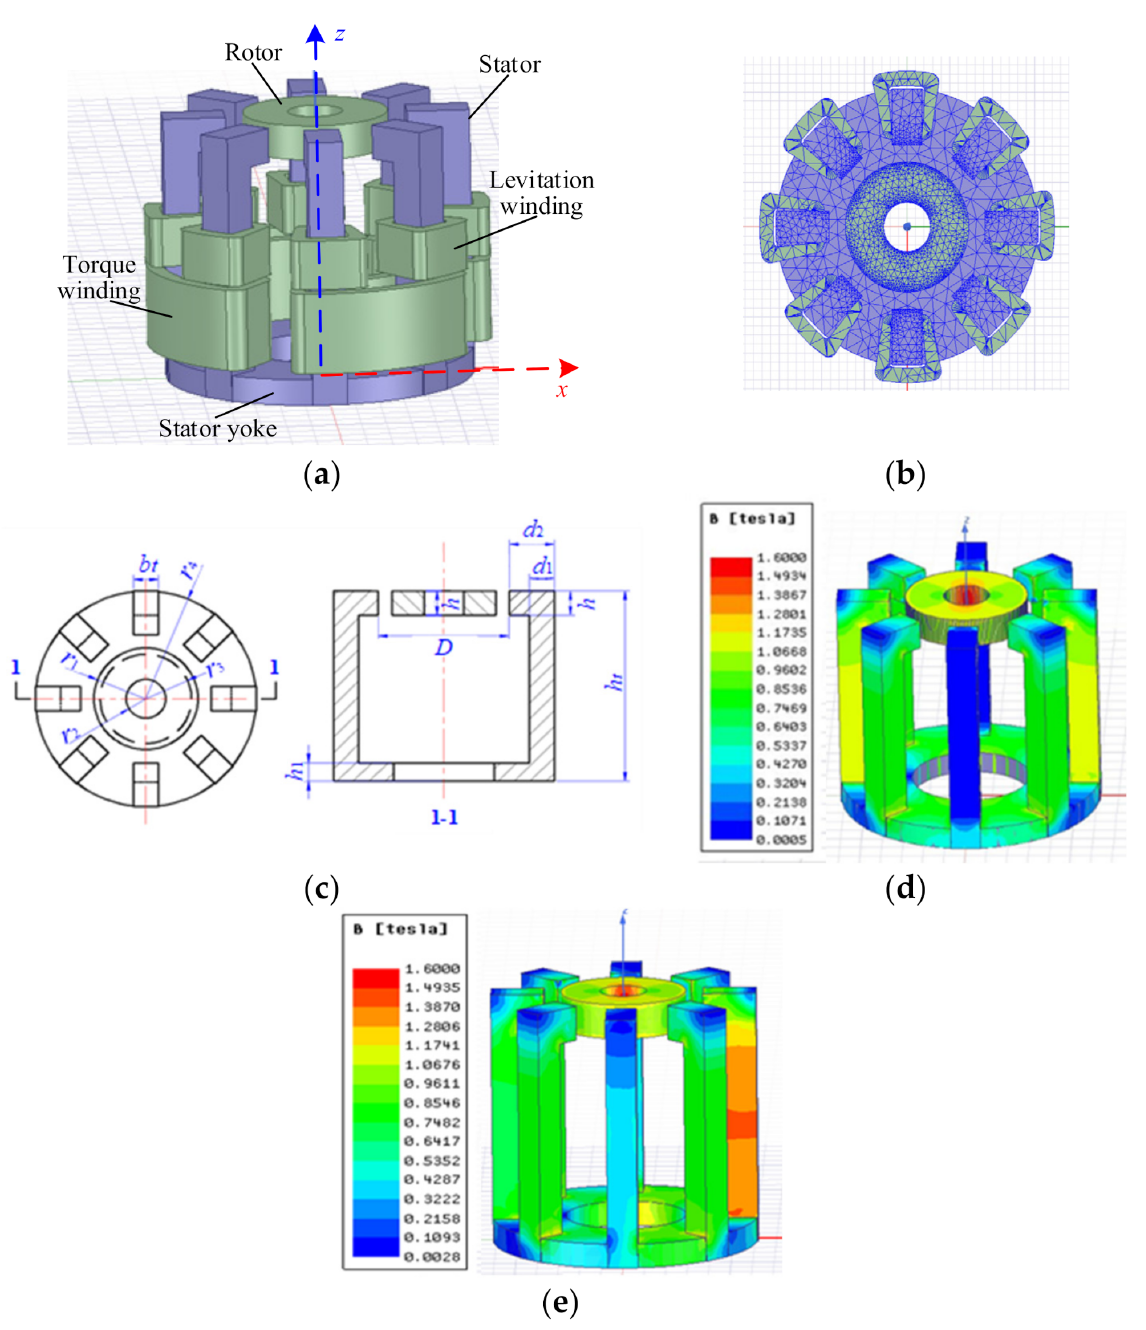
Figure 1. The structure diagram of the BPMSM. ( a ) The virtual prototype of the BPMSM developed in Ansoft Maxwell; ( b ) the meshing of the BPMSM finite element model on the xoy -plane; ( c ) mechanical structural parameters; ( d ) no-load magnetic density cloud map; and ( e ) magnetic density cloud map with 1 A current passing through the suspension force